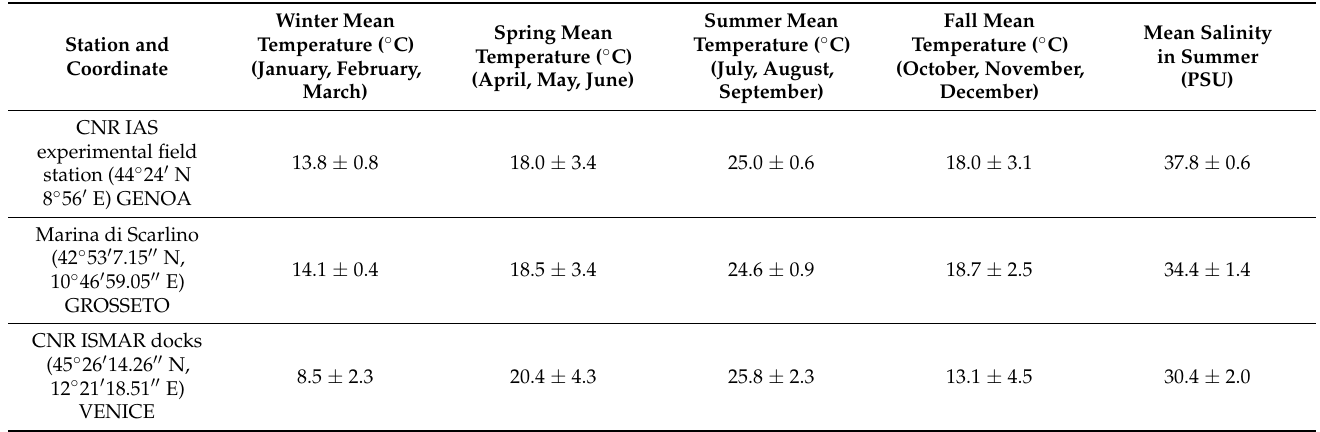
Table 1. Averages of seasonal temperatures and salinity at the three sites.